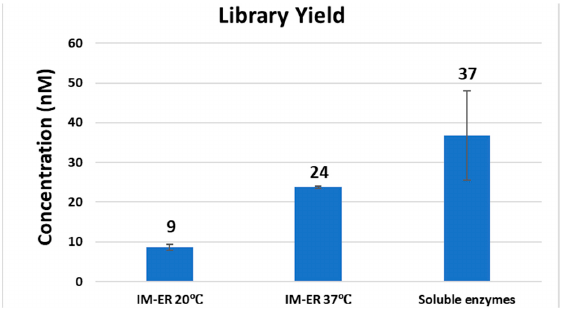
Figure 8. Comparing library yield. The preparation conditions of Clostridium acetobutylicum DNA libraries with immobilized enzymes (IM) or soluble enzymes were described in Figure 7 legend.